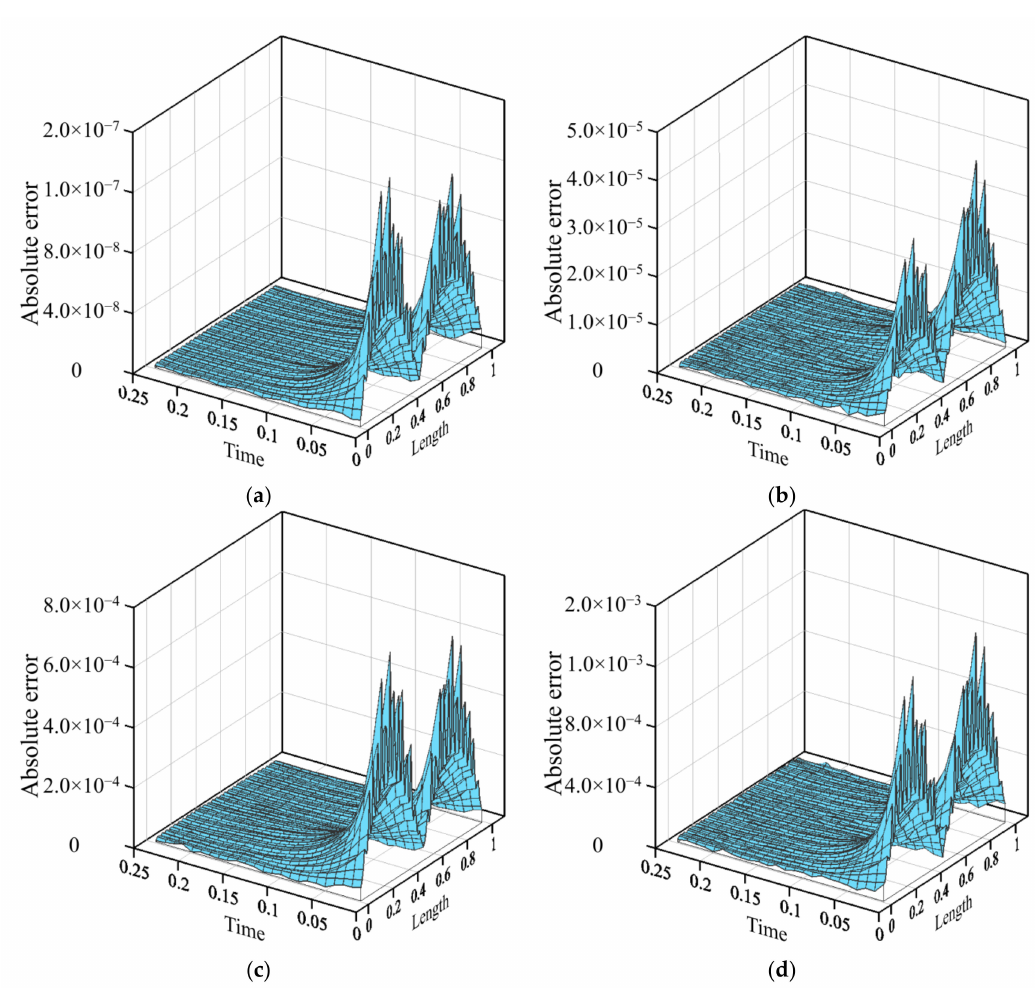
Figure 13. Absolute error of the computed temperature: ( a ) e = 0, ( b ) e = 0.01, ( c ) e = 0.1, ( d ) e =